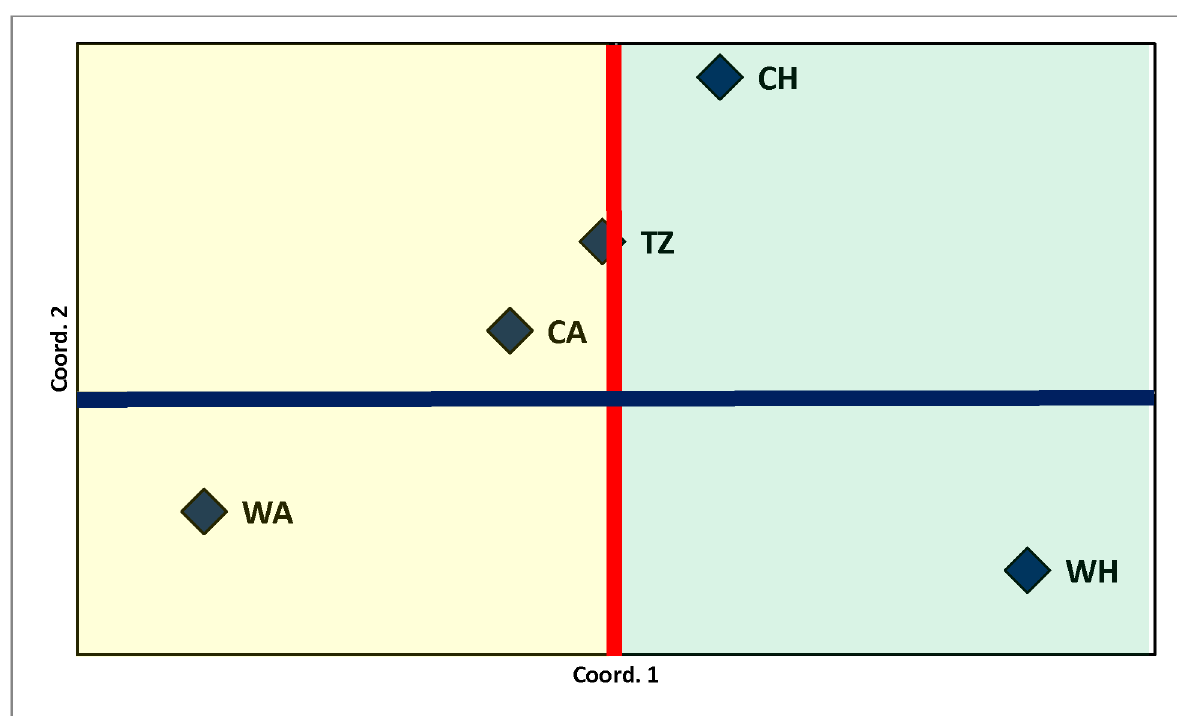
Fig 4. Principal coordinate analysis showing the relative positioning of cool arid (CA), cool humid (CH), transition zone (TZ), warm arid (WA) and warm humid (WH) ecoregions using 66 SNP markers.